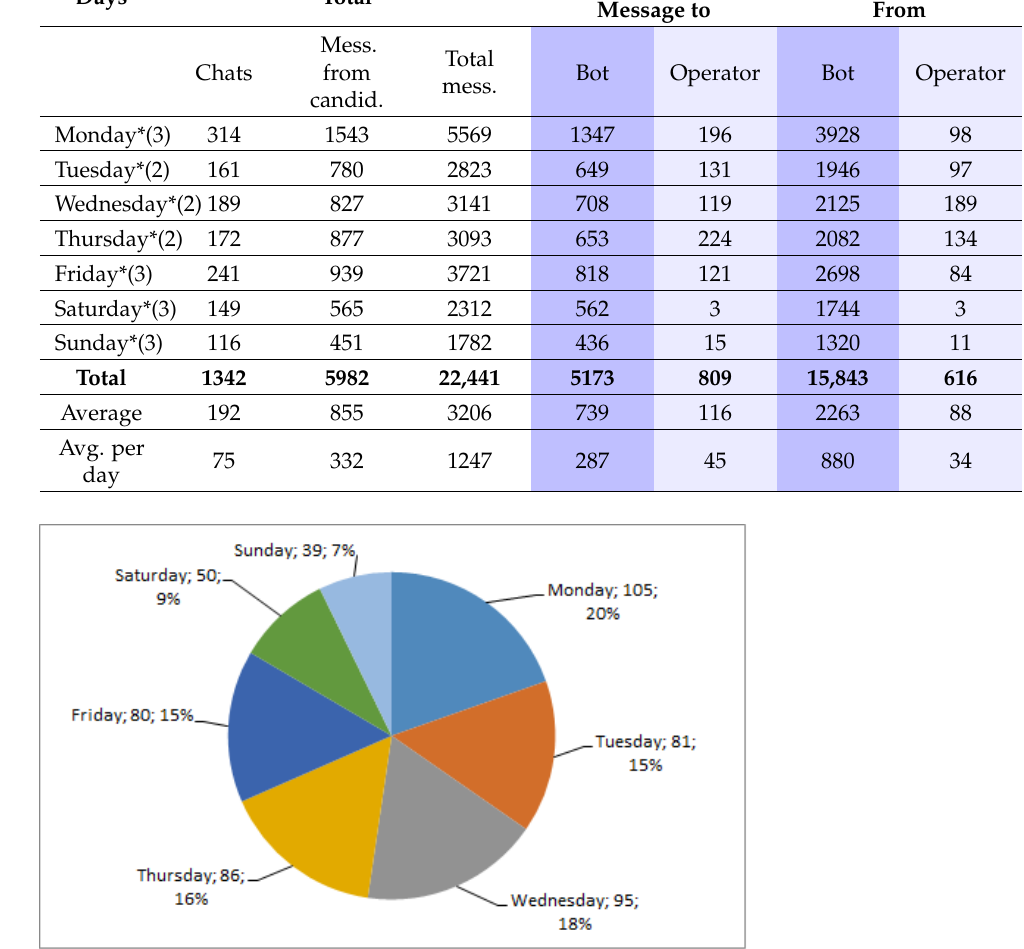
Figure 10. Average weekly opened